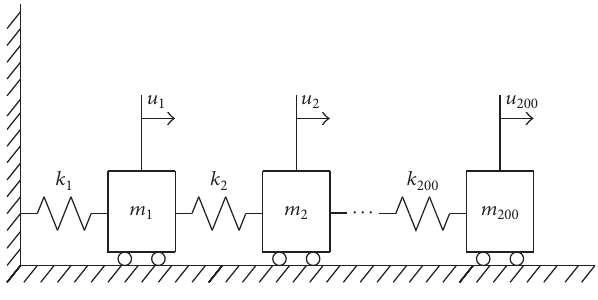
Figure 5: 200-DOF spring-mass system. Table 1: Total time consumption (sec).